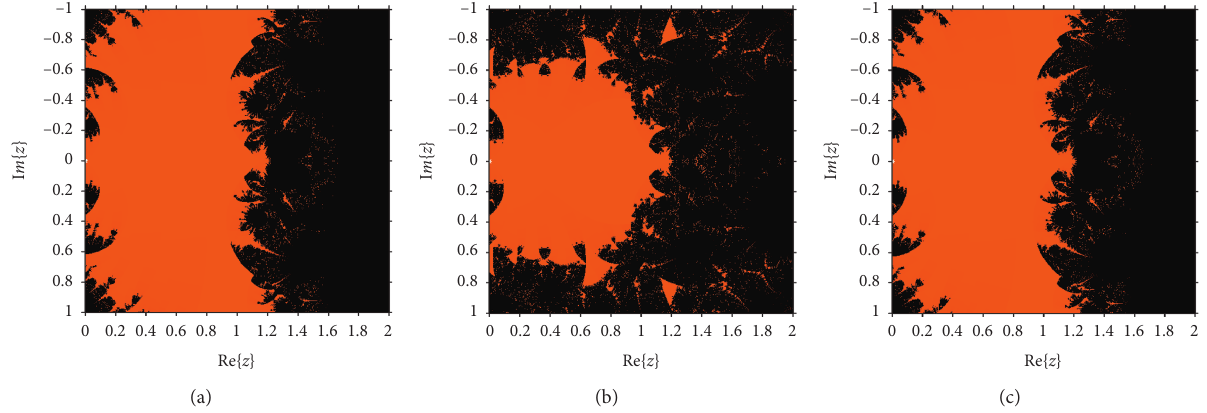
Figure 6: Basins of attraction of (a) SFM1, (b) SFM2, and (c) SFM3 for g